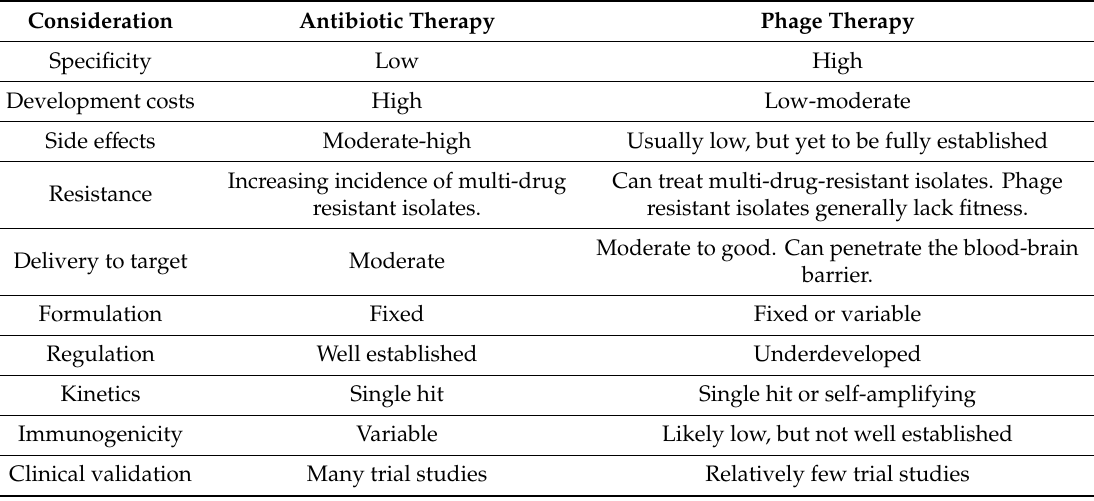
Table 2. Advantages and disadvantages of phage vs. antibiotic therapy for the treatment of bacterial